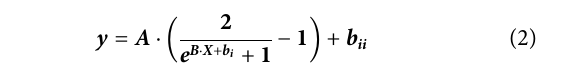
Frontiers in Bioengineering and Biotechnology |